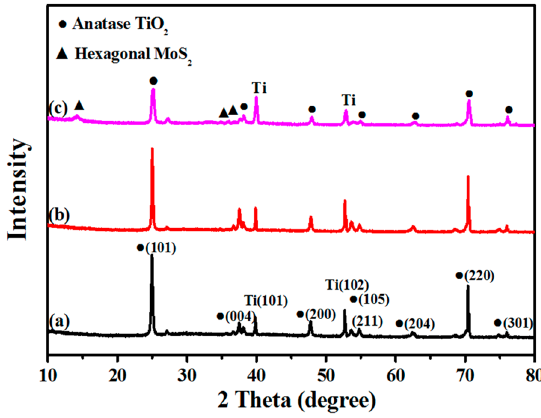
Figure 4. XRD patterns of (a) TiO 2 NTs; (b) TiO 2 NTs/Ag; and (c) TiO 2 NTs/Ag/MoS 2 .